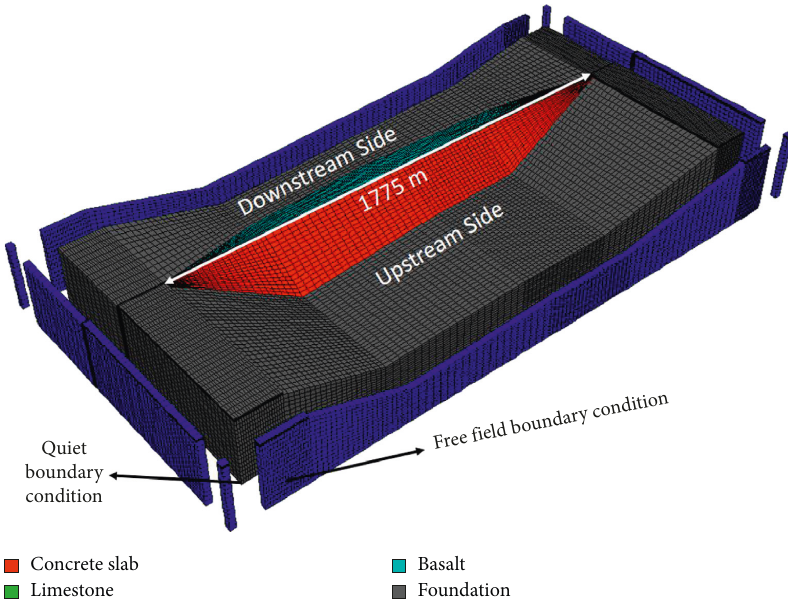
Figure 10: 3D finite difference model of the Ilısu dam.